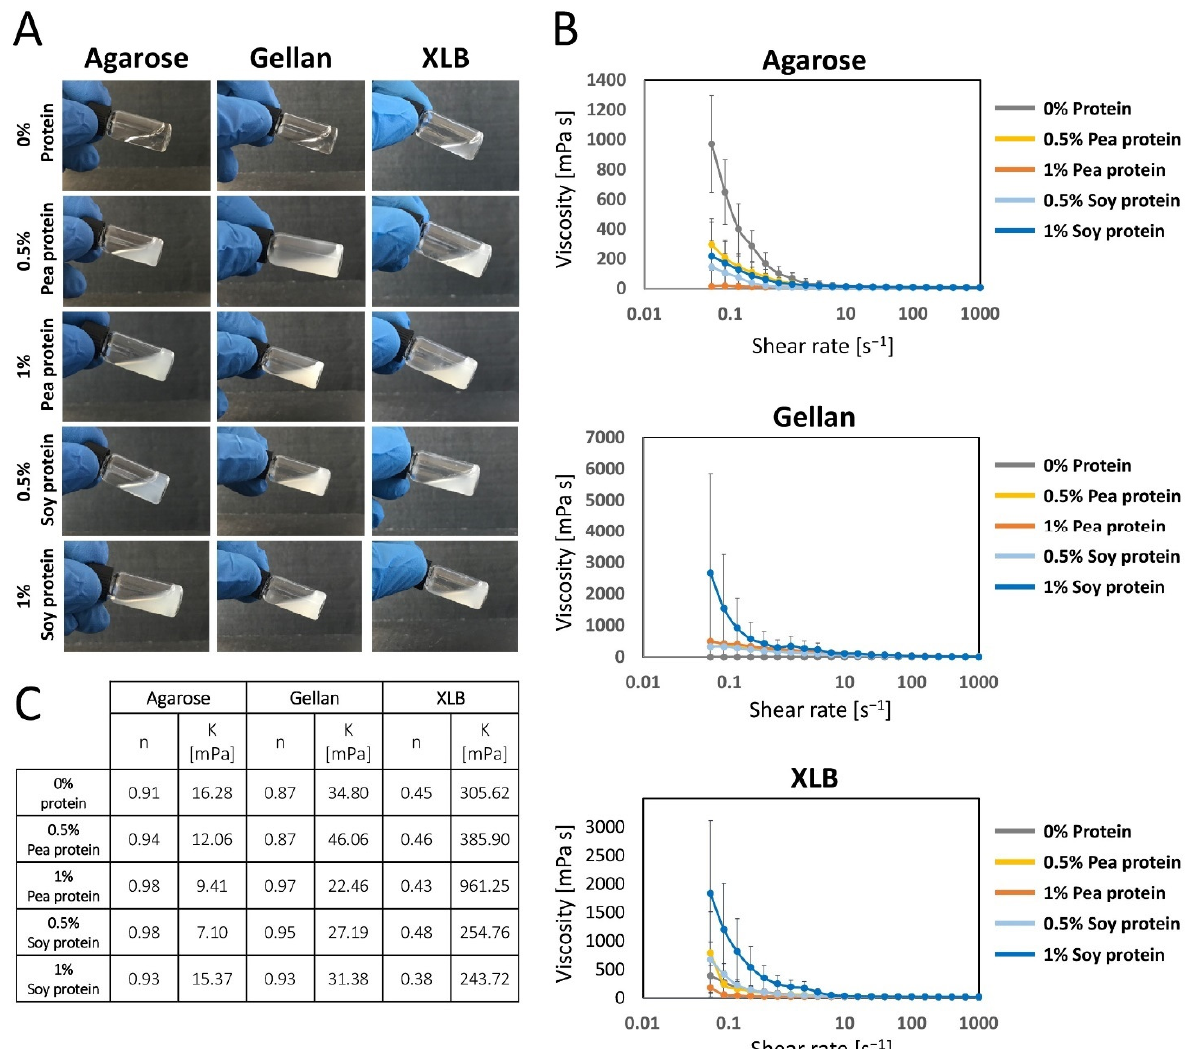
Figure 3. Sol state properties of agarose, gellan and XLB gels blended with 0%, 0.5% and 1% of pea or soy protein. ( A ) Liquid form of the different polysaccharide blends. ( B ) Viscosity over log 10 (shear rate) curves of the different polysaccharide blends (agarose and gellan at 37 °C, and XLB at 65 °C). Error bars represent standard deviations. ( C ) Determined flow exponent (n)- and consistency factor (K)-value of the different gels.